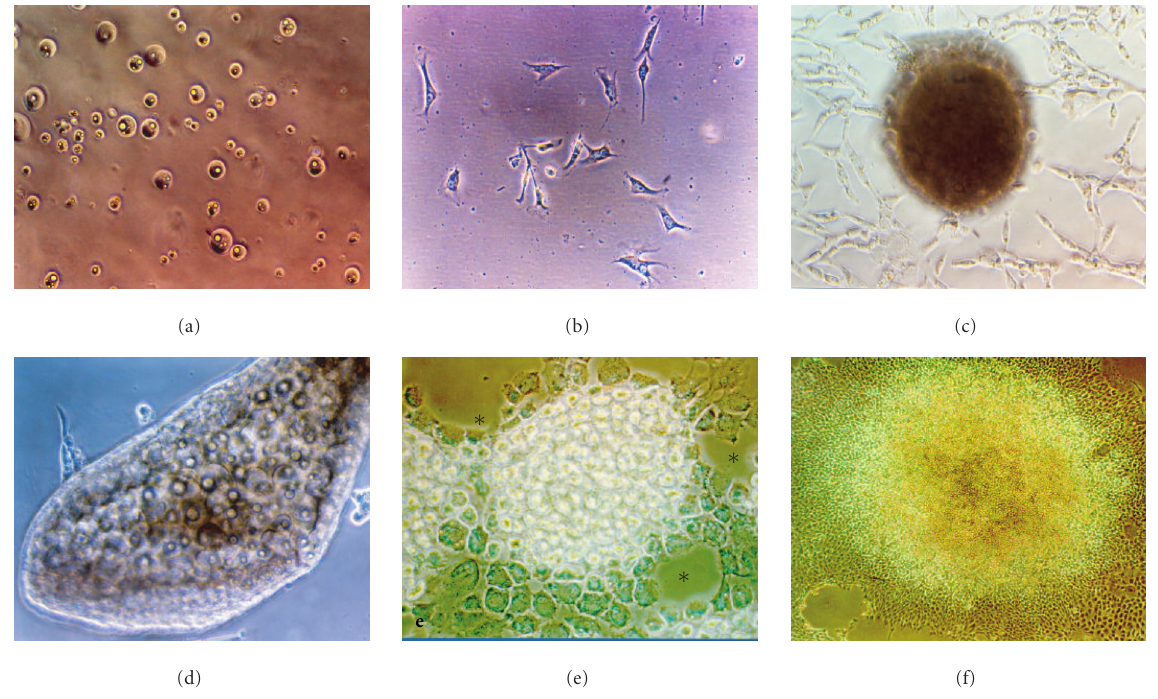
Figure 1. Phase-contrast microscopy. (a) Newly isolated chondrocytes filtered through nylon mesh, showing their characteristic round shape in suspension, OM OM × 50. (b) Mesh-filtered cells adopt a flattened fibroblast-like phenotype on plastic substrata, OM × 50. (c) Nodules formed by unfiltered cells, OM × 10. (d) Small cartilage-like masses occasionally formed by nodules from unfiltered cultures, OM × 50. (e) Hollow circular structures (asterisk). (f) In unfiltered cultures, many chondrogenic plates and nodules are surrounded by cells forming a radial pattern, OM × 10.